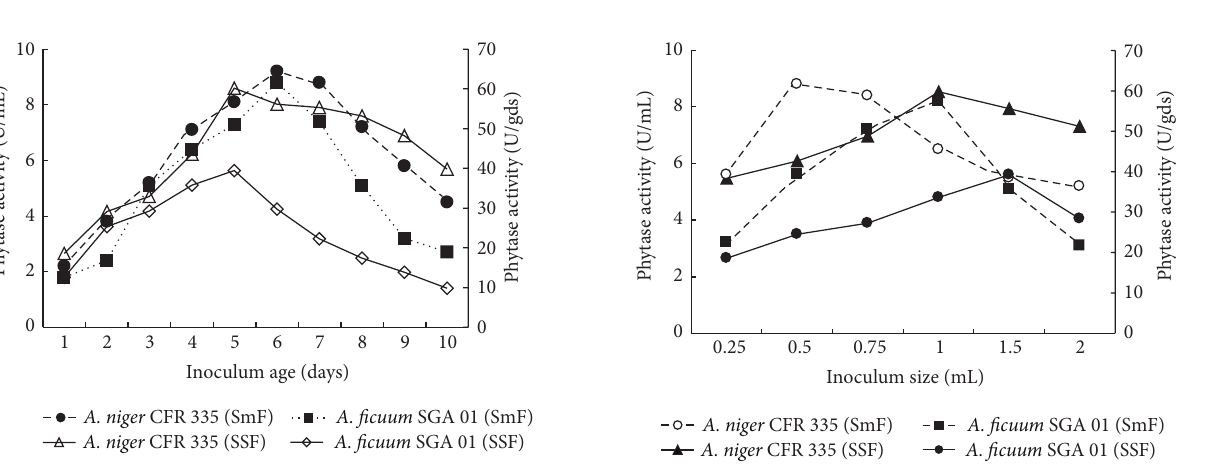
Figure 2: Effect of inoculum size on phytase production by Asper- gillus niger CFR 335 and Aspergillus ficuum SGA 01 in submerged and solid-state